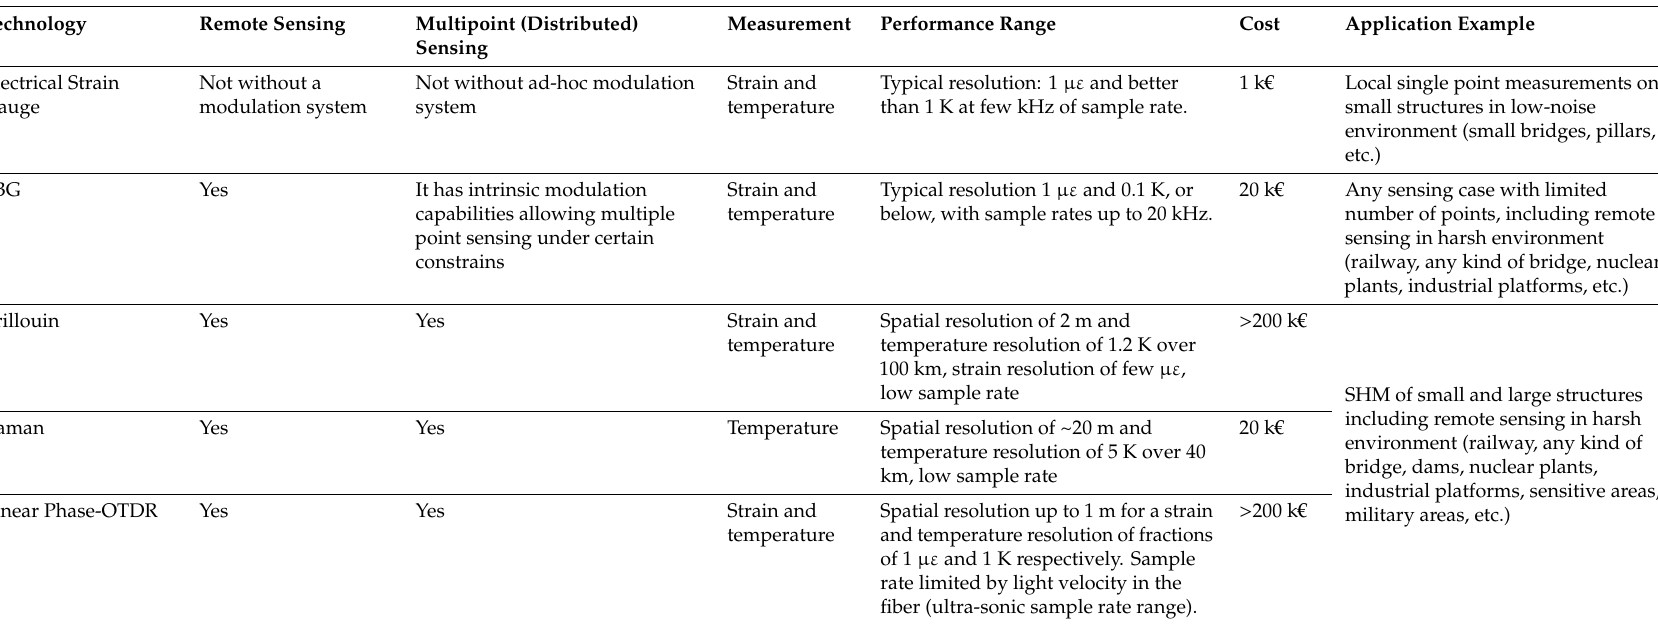
Table 1. Technology comparison for strain and temperature measurement in structural health monitoring